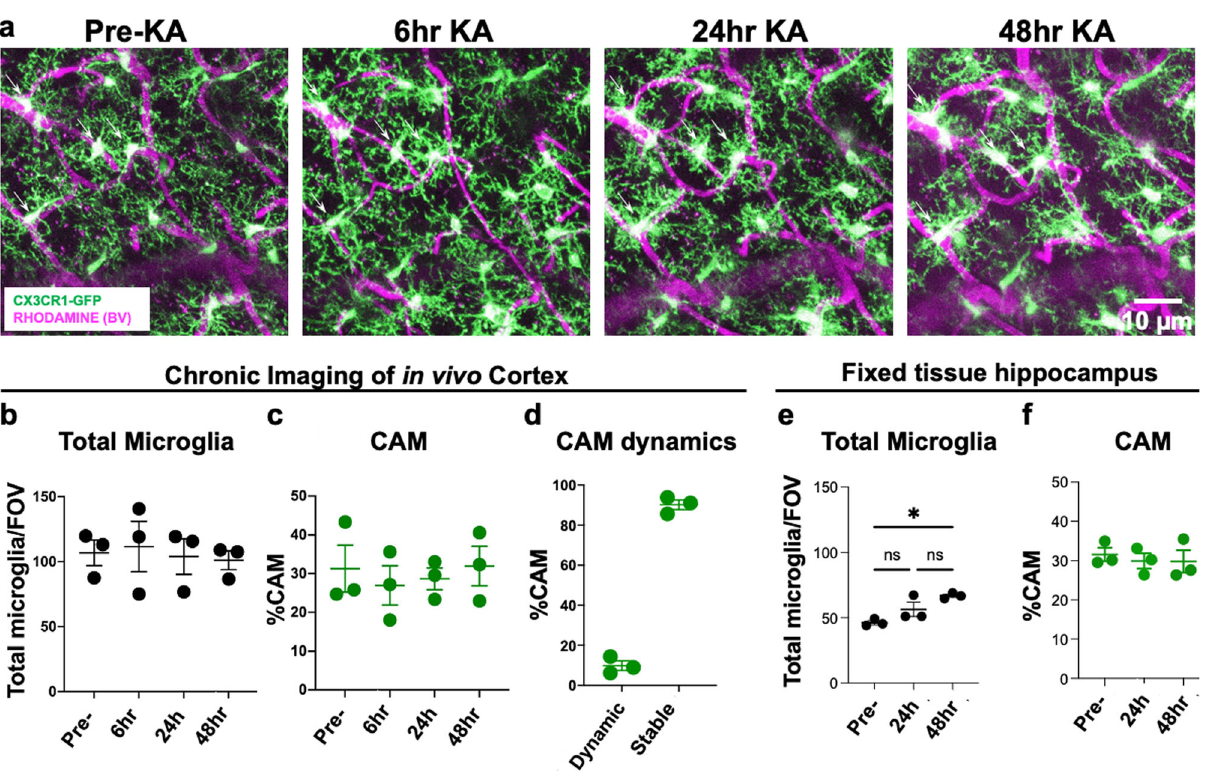
Fig. 5 CAM interactions are not altered by increased neuronal activity. a Representative in vivo two-photon projection images from the same fi eld of view in a CX3CR1 GFP/ + adult brain showing capillary- (magenta) associated microglia (green) before and up to 48 h after KA-induced seizures. b , c Quanti fi cation of total microglial ( b ) and capillary-associated microglial ( c ) density over time before and following seizures. d Quanti fi cation of the stable and dynamic CAMs following seizures. e – f Quanti fi cation of total microglial ( e ) and capillary-associated microglial ( f ) density from fi xed slices in the hippocampus following seizures. n = 3 mice each. Data are presented as mean values ± SEM. * p < 0.05. n.s. not signi fi cant. Two-sided unpaired Student ’ s t test in b , c , e , and f